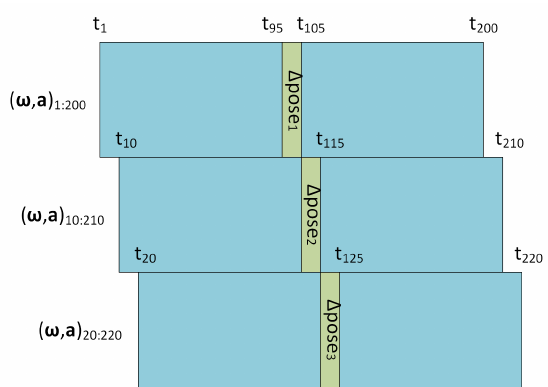
Figure 2. Input and output on time-axis. IMU data windows are overlapped over time (blue), and both past and future frames are used when computing the relative pose at each ∆ pose moment